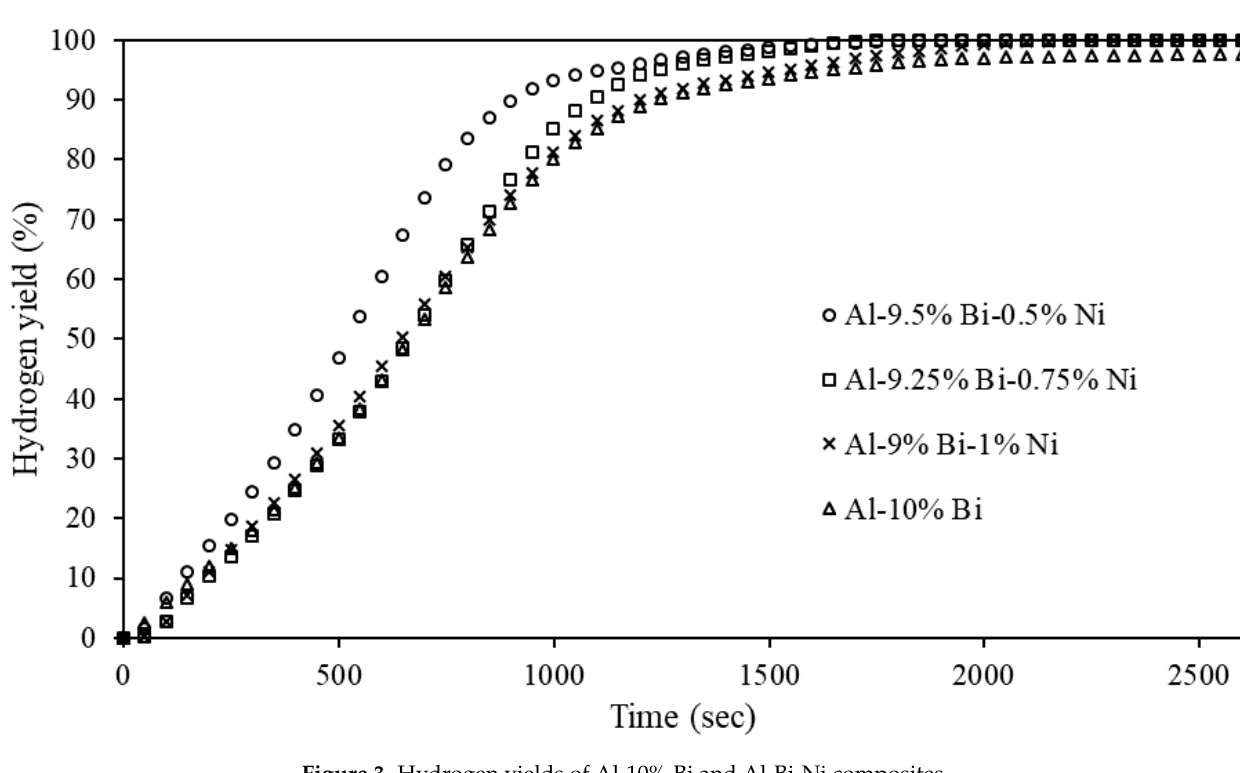
Figure 3. Hydrogen yields of Al-10% Bi and Al-Bi-Ni composites.